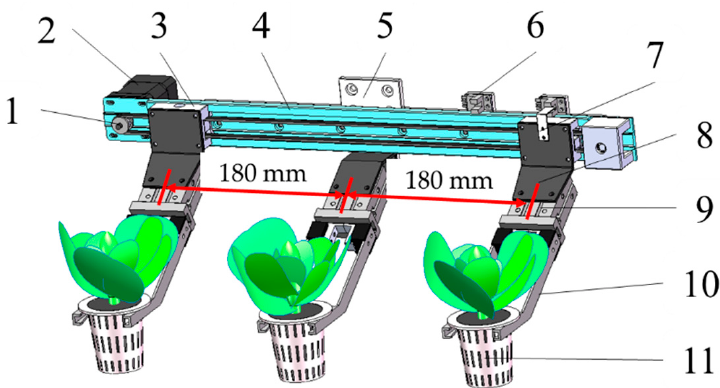
Figure 15. Three-claw transplanting actuator: 1. Pulley. 2. Stepper motor. 3. Slider. 4. Guide rail. 5. Main board. 6. Sensor. 7. Induction sheet. 8. Fixing plate. 9. Pneumatic finger. 10. Gripper. 11. Trans-